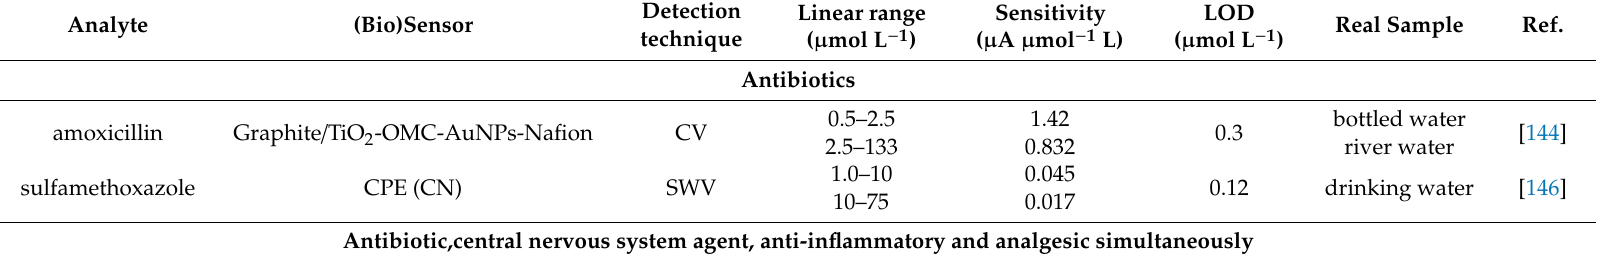
Table 5. Other carbon nanomaterials used in electrochemical sensors for emerging pharmaceutical pollutants in